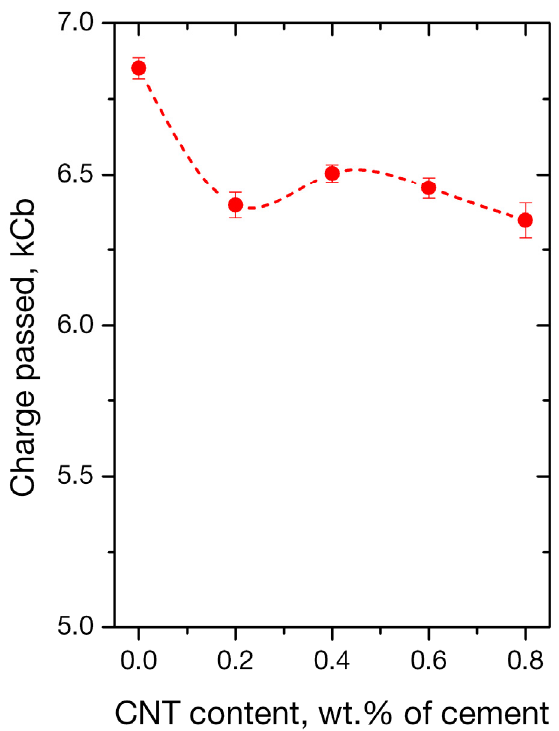
Figure 6. Total charge passed through specimens with different CNT loadings.